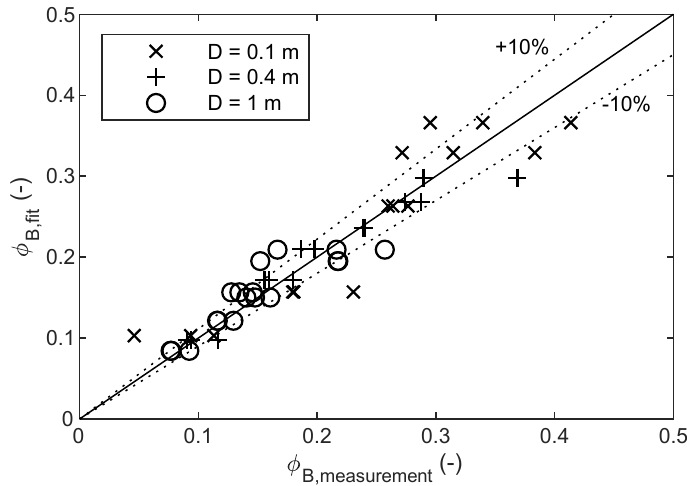
Figure 7. Parity plot of the measured bubble phase holdup and the developed correlation for all investigated plant diameters.